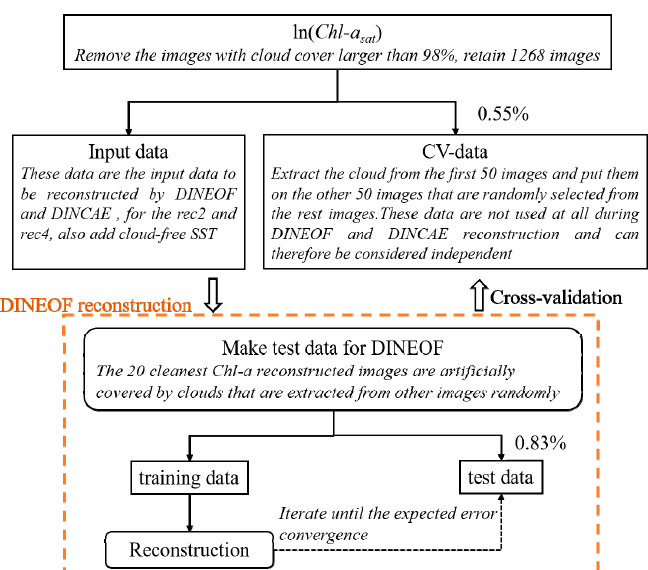
Figure 3. Validation data selection process for DINEOF, where the percentage represents the rate of cross-validation points and 52,112,264 of the total number of sea pixels.